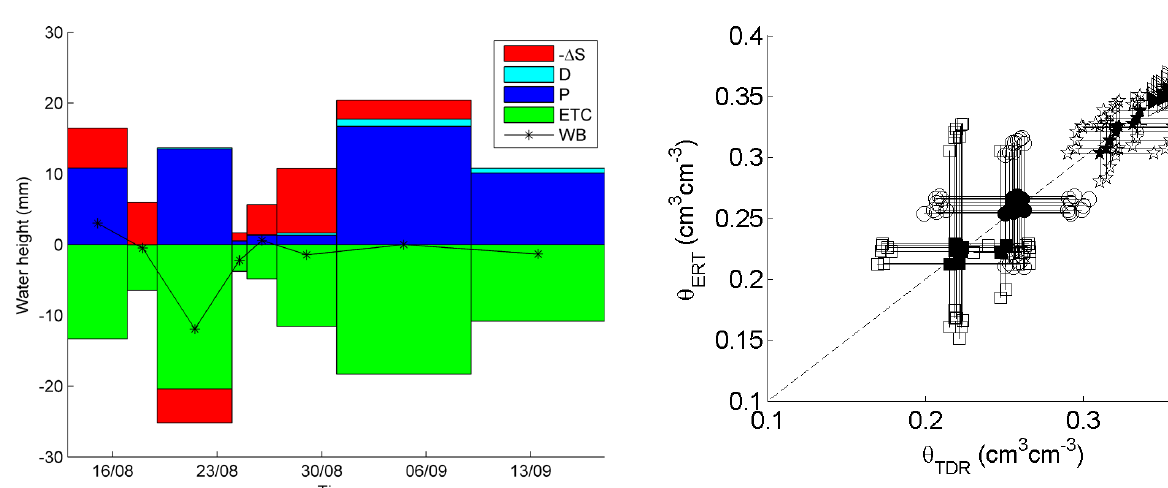
Fig. 6. Water balance (WB) between the nine ERT measurement times calculated with Eq. (12). Input includes rainfall, P in mm (blue); capillary rise, D in mm (cyan); and the output is the ETC in mm (green). The water stock variation, − 1S in mm (red), is positive when SWC decreases and negative for an increase of SWC. The black line (WB) corresponds to the difference between the input and stock change and the output.